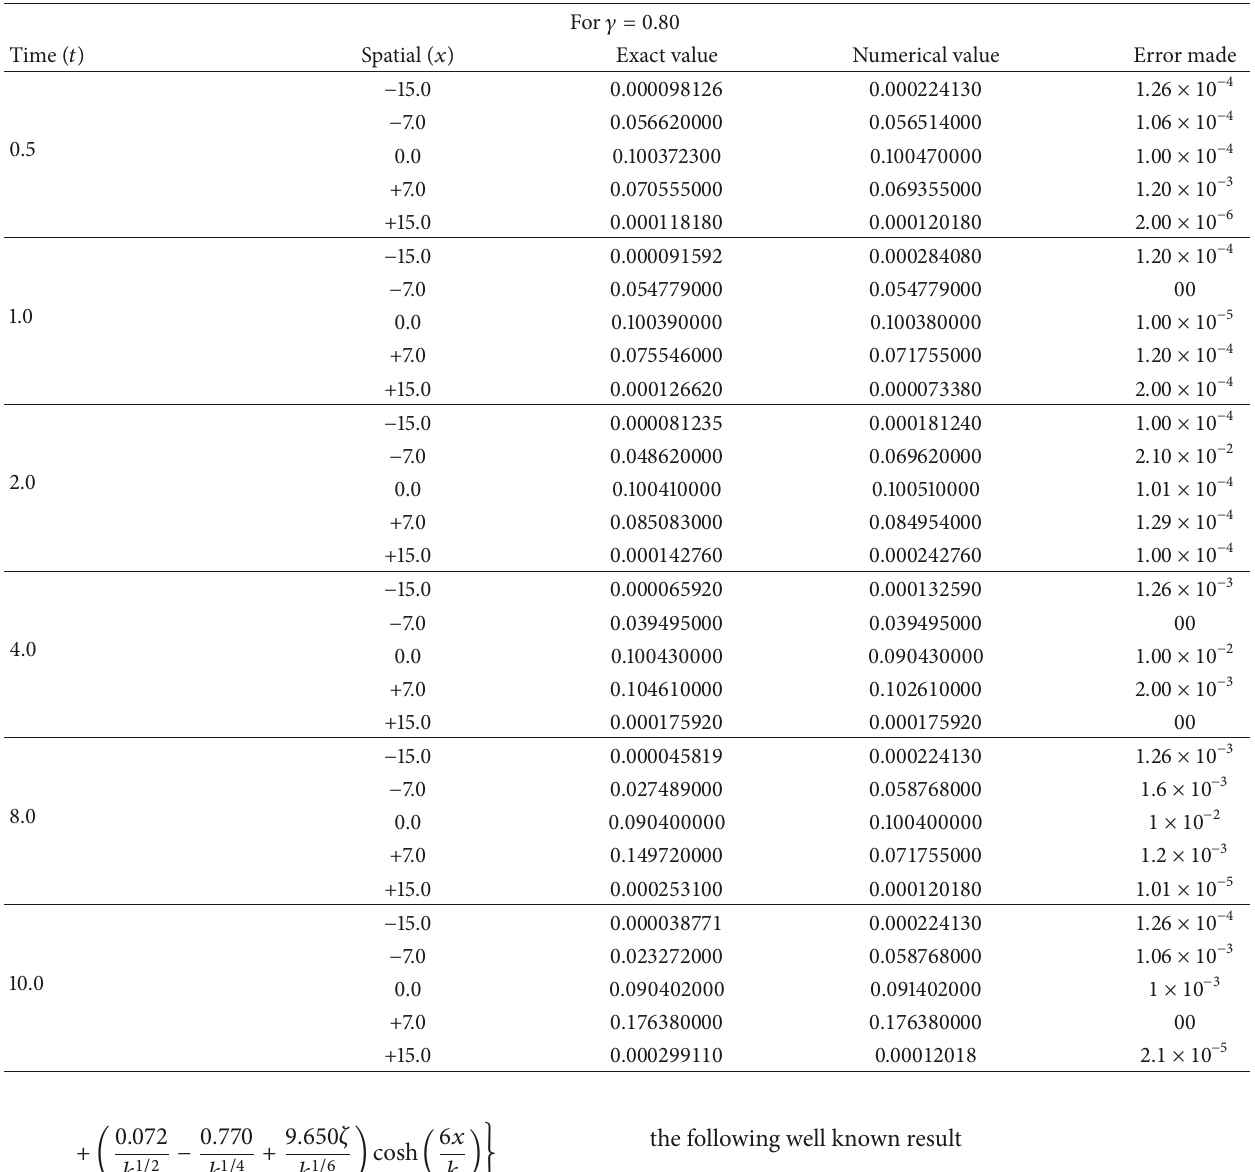
Table 1: Some values for numerical and exact solutions to the seventh order KdV equation expressed with the CFFD given in (5) at 𝑘 = 2.5 , 𝑑 = 4.0 , and 𝛾 = 0.80.